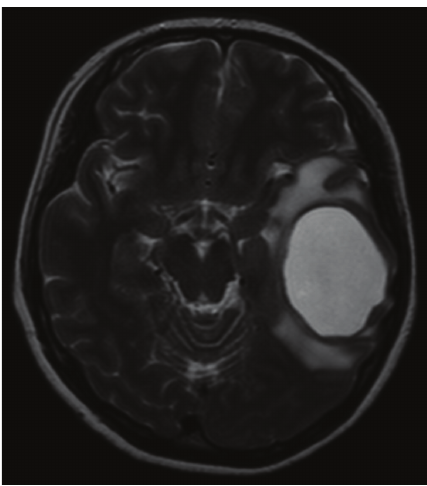
Figure 1: Brain magnetic resonance imaging (horizontal) indicating a solid mass in the left temporal lobe.